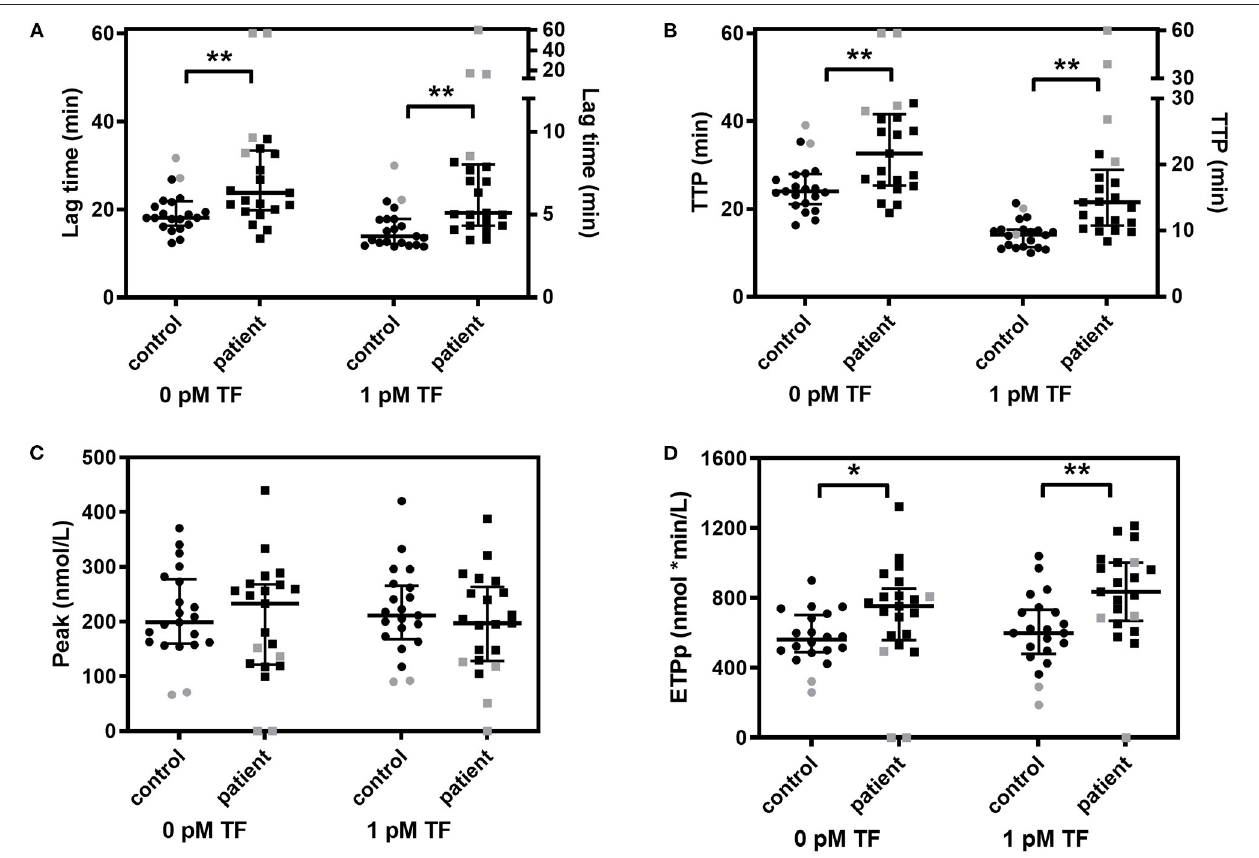
FIGURE 1 | Whole blood thrombin generation in multiple myeloma (MM) patients and controls. Thrombin generation was stimulated with 0 pM and 1 pM TF in whole blood of MM patients and controls. (A) Lag time, (B) peak thrombin, (C) time-to-peak (TTP) and (D) endogenous thrombin potential until the peak (ETPp) are presented. Median and IQR are presented as error bars. Patients and controls on anticoagulant medication are indicated in gray. * P < 0.05, ** P < 0.01.